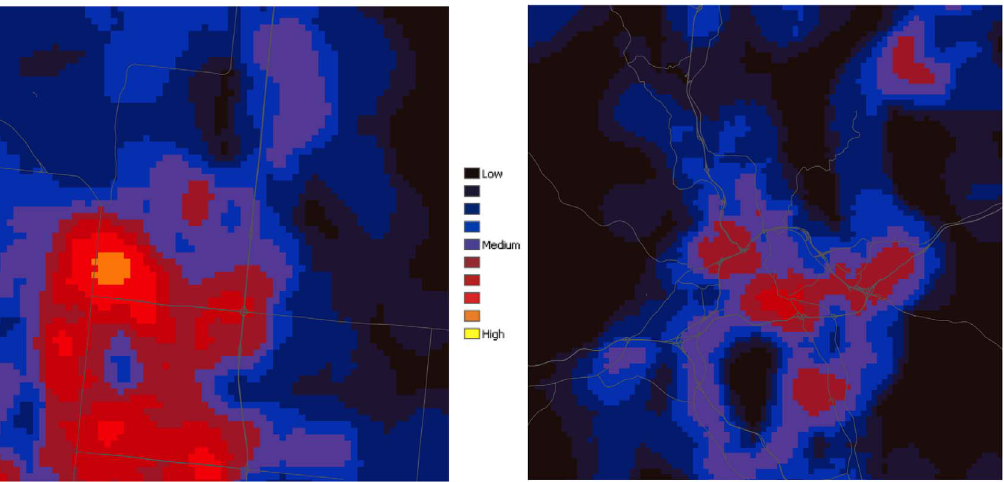
Figure 7. The diversity of land uses shown for Fort Collins, CO (left) and Ashville, NC (right). Higher diversity is depicted in yellow/red, with lower diversity shown in blue and dark blue. Major highways and interstates are labeled for reference.